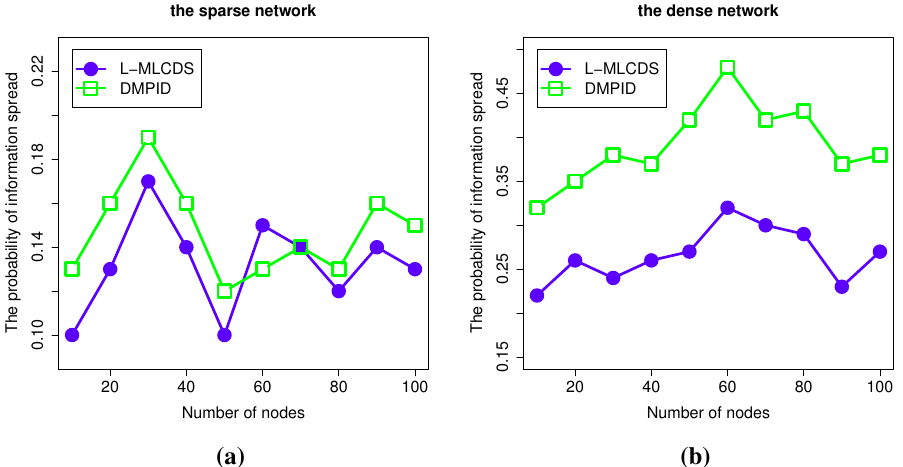
Figure 6. Simulation results for the information spread probability. The information spread probability in ( a ) the sparse network; ( b ) the dense network.